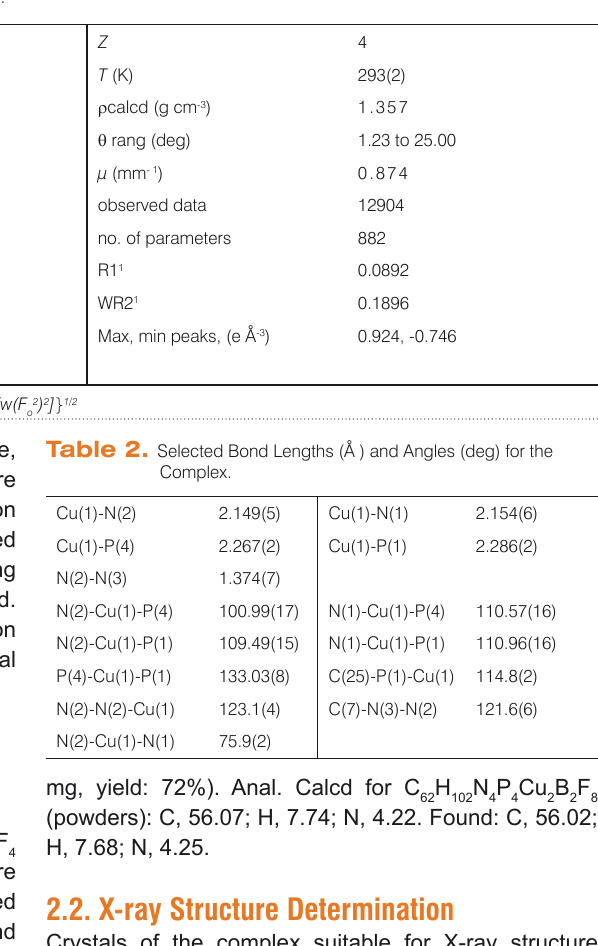
Table 1. Summary of X-ray Crystallographic Data for the Complex.